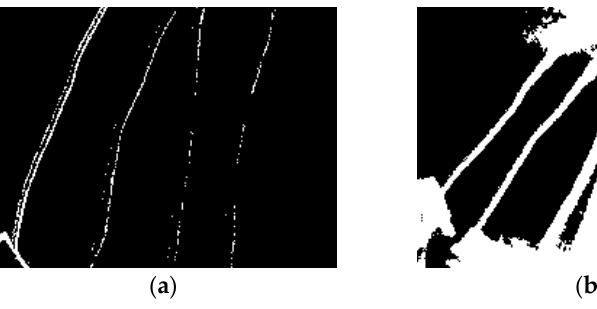
Figure 12. Examples of evaluated results using the trained models. ( a ) the four wires are correctly identified in the picture, giving it a high accuracy ( b ) wires have been identified but are included in the same class as the misidentified background, giving it a false high accuracy ( c ) the wires have been misidentified as background but it gives a false high accuracy as the majority of the image is background.